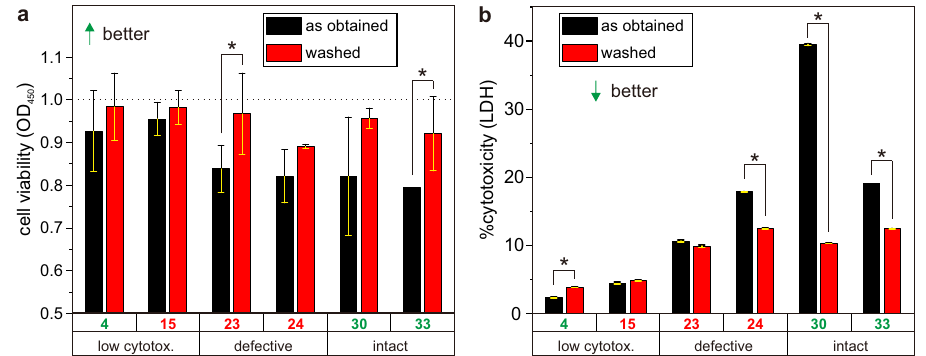
Fig. 5 Correlation between fraction of persistent inorganics (PI) and degrees of cytotoxicity. a Changes in cell viability, and b %cytotoxicity before and after consecutive ultrasound bath assisted washing with hot acid (1 M) and ethanol, chloroform, ethanol, lye (0.1 M), and fi nally, three times DI water at 60 ° C for the removal of potential impurities. Similar concentrations (10 µg/ml) of the fi nally freeze-dried products were used. Samples in green and red denotes NGM int and NGM def respectively. *Denotes statistically signi fi cant difference between the samples ( p < 0.05). Error bars represent standard deviation between three independent (scatter and loading plot) was constructed, in which the scatter (Fig. 6a). The scattered data in the PCA biplot are individual data points are the principal component (PC) scores of each sample, points which suggests that three apparent clusters (block = and the arrows represent the loading of each sample (i.e., the cell NGM int , open = NGM def ) are formed. The blue cluster represents the most cytocompatible materials (high WST-1) and slight viability and cytotoxicity). The analysis computed two signi fi cant overlaps with the red cluster, both dominated by NGM int , components: PC1 and PC2 that accounts for the highest and indicating higher overall cell viability by the NGM int . The second highest variance probabilities in the dataset. In this materials from the green cluster presented high toxicity mainly analysis, the lower the PC1 score, the more cytotoxic is the induced by membrane damage (LDH release). Finally, an material and vice-versa. Clearly, PC1 predominantly contributes inspection of the loading plot clearly indicates that PC1 mainly (86.83%) to the total variation of the cell viability and cytotoxicity